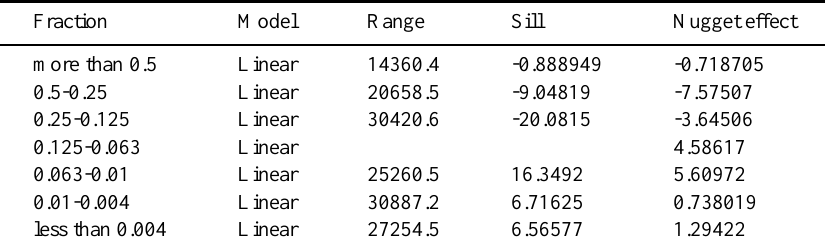
Table 2. Types of cross semivariogram models between depths and fractions and the parameters: range, sill and nugget